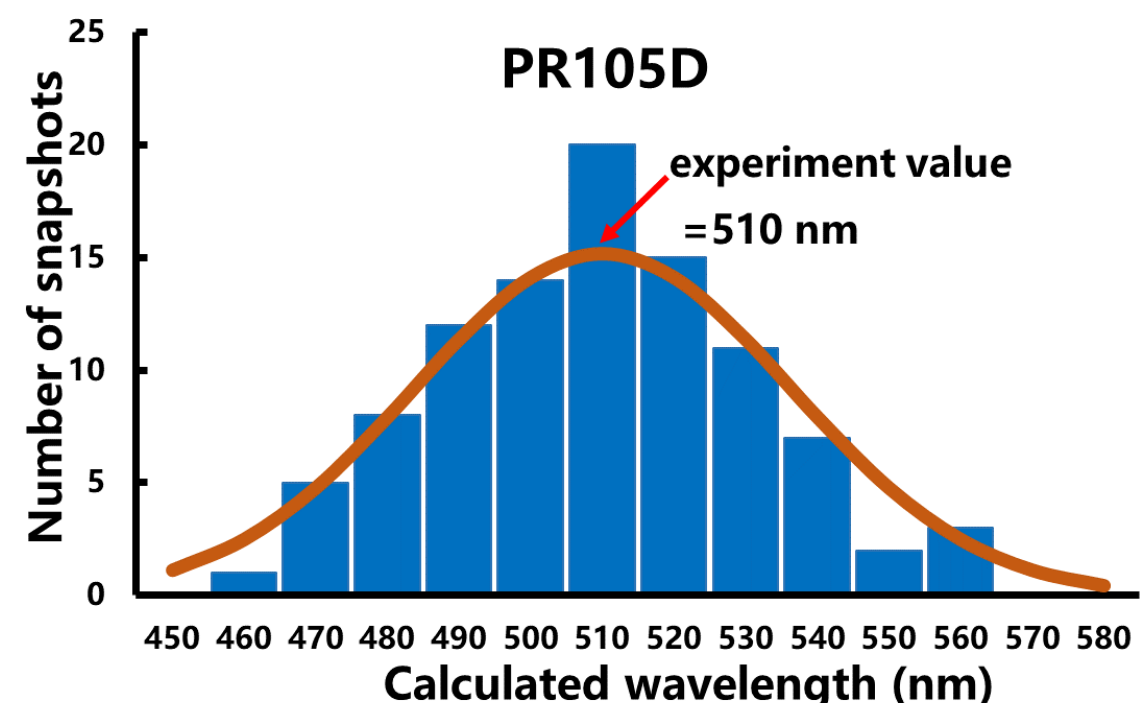
Figure 5. Distribution of calculated absorption wavelengths for one hundred conformations of PR105D extracted from the last ps of QM/MM MD trajectory. The average value of calculated results is 512 nm, which is in excellent agreement with the experimental value of 510 nm.